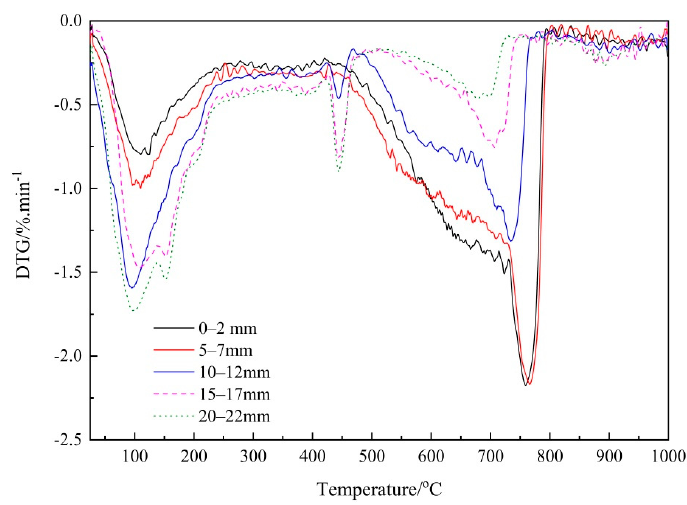
Figure 8. DTG curves of the carbonated GGBS/PC paste samples at five depths.